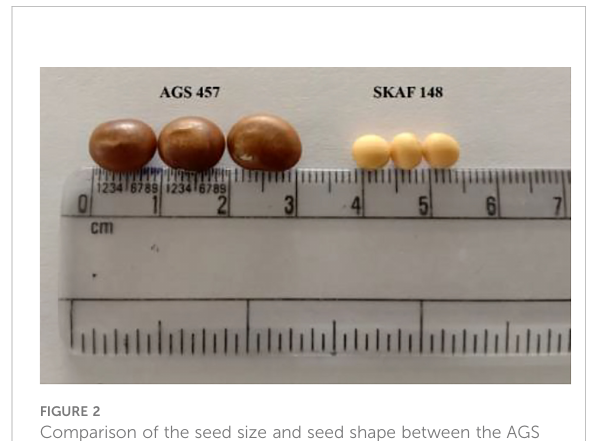
FIGURE 2 Comparison of the seed size and seed shape between the AGS 457 and SKAF 148.